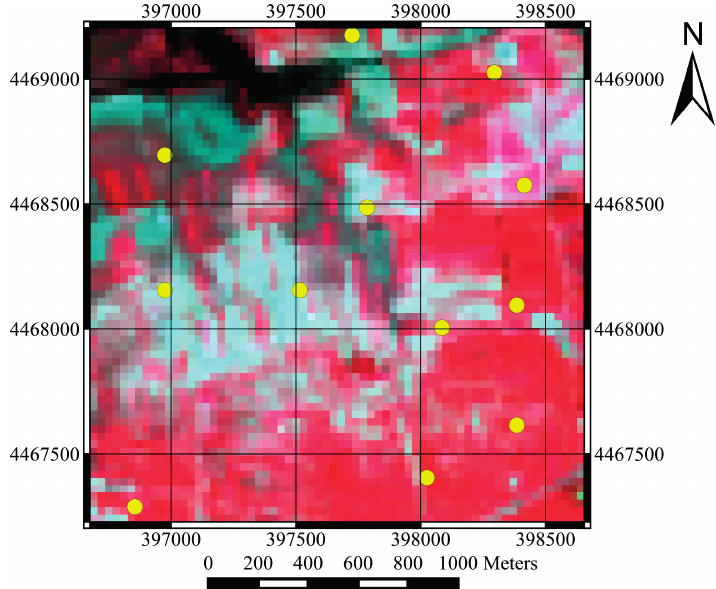
Figure 3. The spatial distribution of the ESUs over the 2 km × 2 km study area at the Huailai Remote Sensing Experimental Station, China. The projection is UTM 50 North, WGS84. The background image is a false-color composite image from Landsat8/TM that was acquired